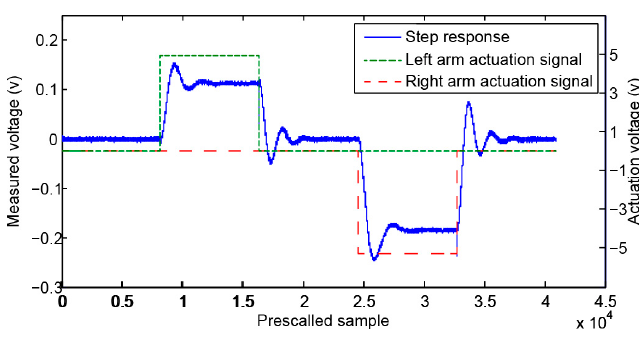
Figure 9. Step responses of the structure.